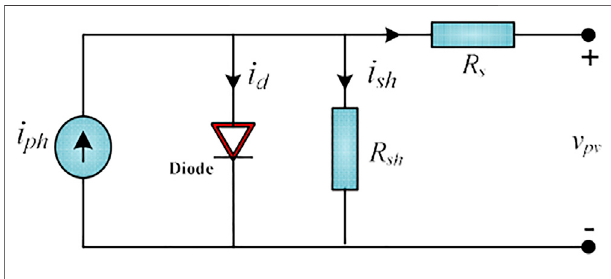
FIGURE 2 | One-diode model-based equivalent circuit of PV